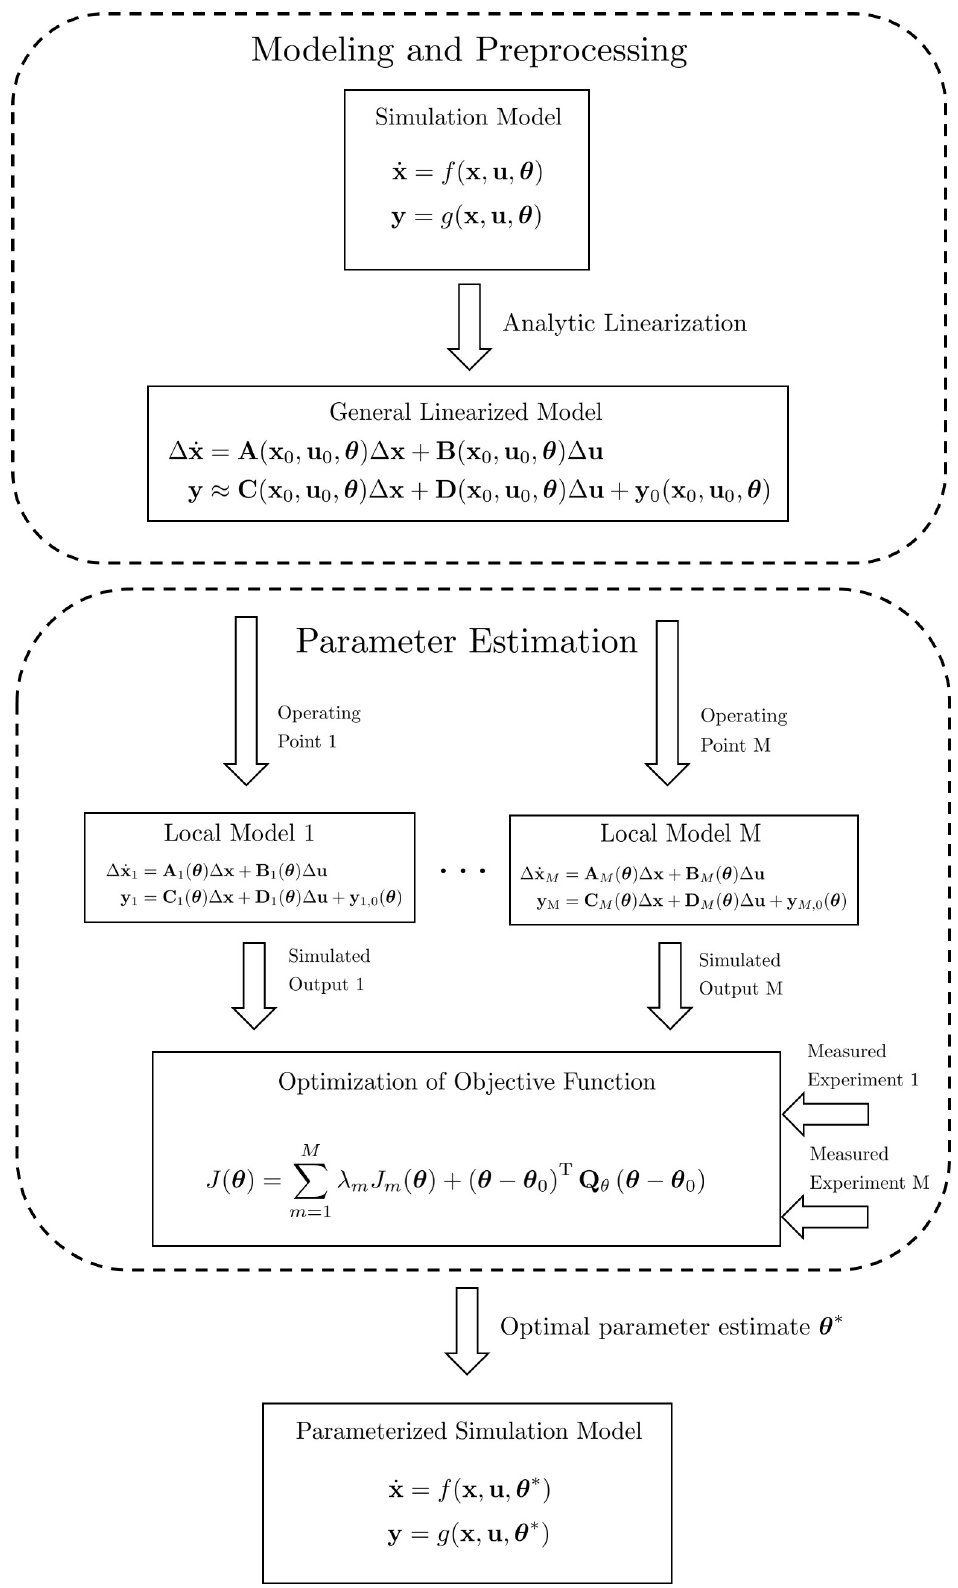
Figure A1. Workflow of the model parameterization via multiple analytic local linear